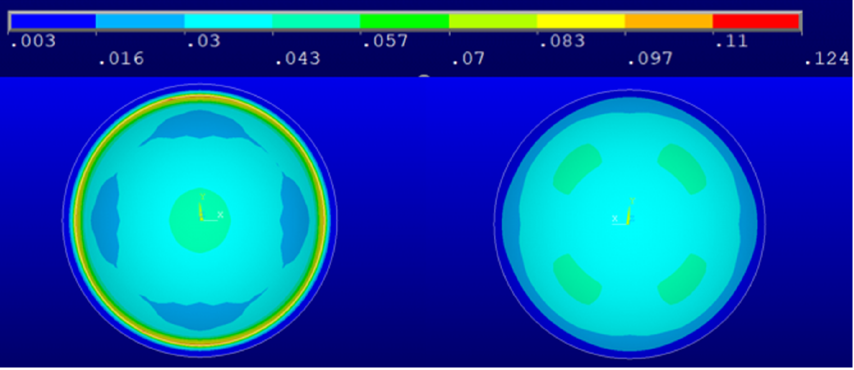
Figure 7. Von Mises strain distribution in measurement phase for Navarro’s geometry.